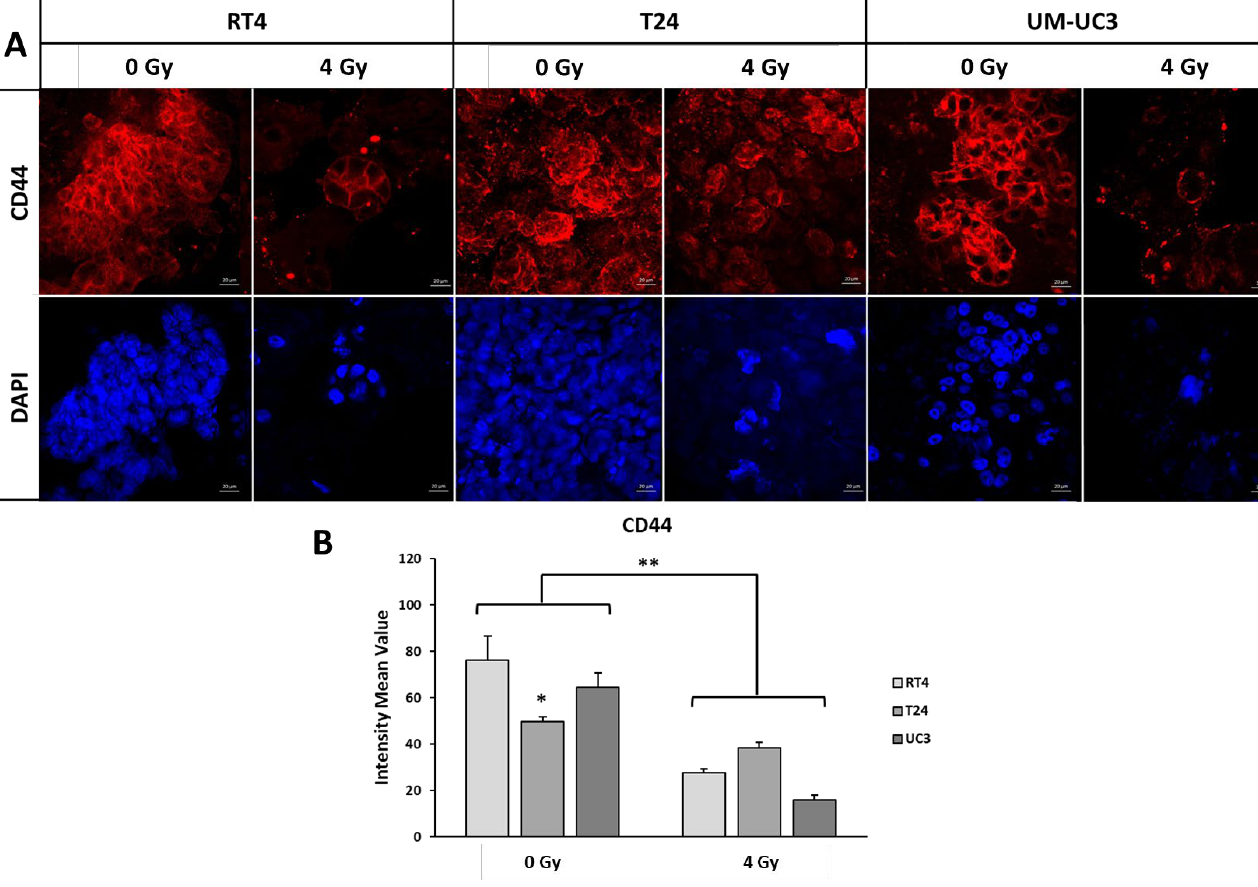
Figure 5. Anti-CD44 IF analysis. ( A ) IF imaging of stem cell marker CD44 and DAPI at 0 Gy and 4 GY for the 3 cell lines cultured in 3D. ( B ) The intensity mean value of CD44 for the 3 cell lines at 0 Gy and 4 Gy. Data was normalized to the control by dividing the intensity of CD44 signal of the irradiation condition by the signal without irradiation. Mann-Whitney-Wilcoxon tests were per- formed for statistical significance (* p < 0.05; ** p < 0.01) .